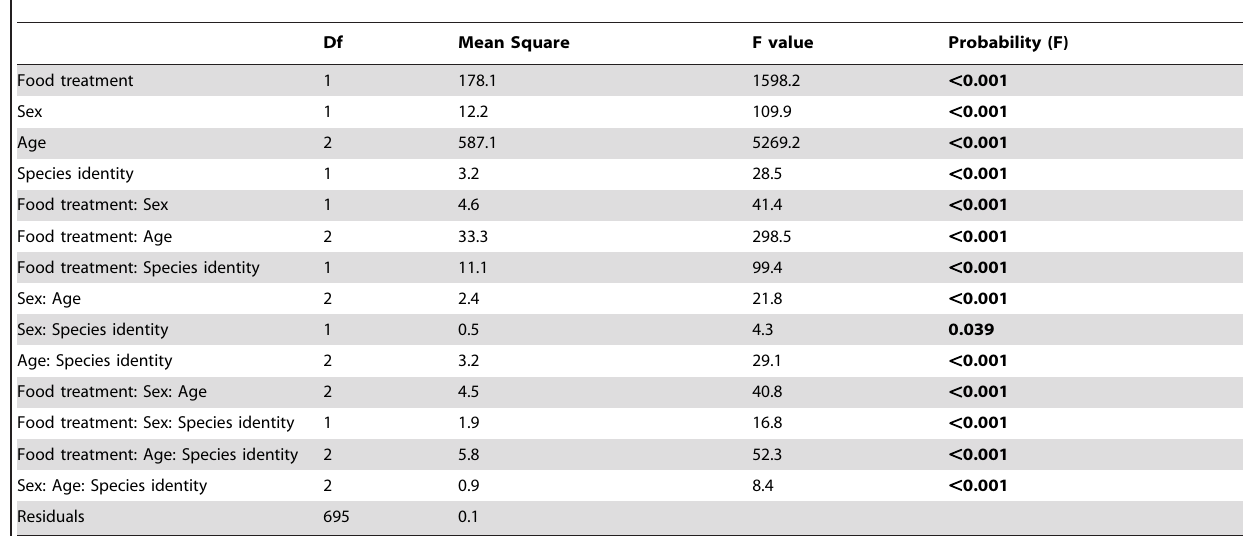
Table 4. Analysis of variance of thoracic fat according to food treatment (fed and starved), sex, age and species identity.